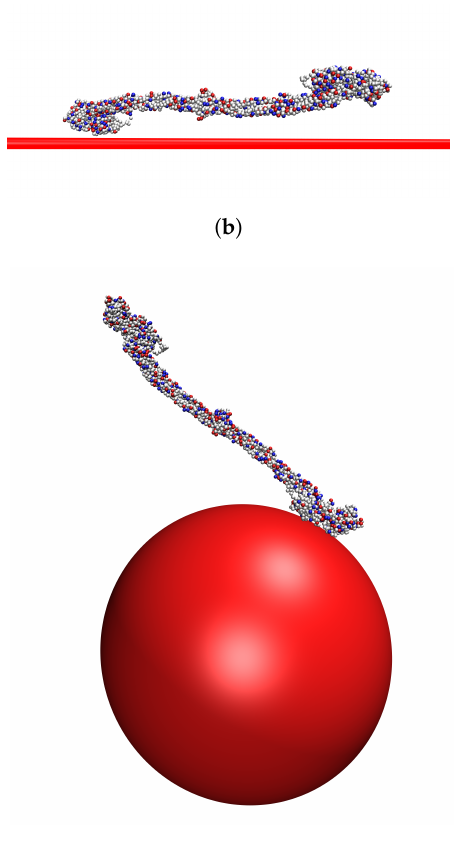
Figure 4. ( a ) The distributions of cosine of the angle between fibrinogen and the normal to the surface it is adsorbed to for two cases: when adsorbed to a nanoparticle attached to a flat surface and when adsorbed to a flat surface without nanoparticles. The surface charge density is − 0.005 e /Å 2 . ( b ) A typical orientation of fibrinogen adsorbed on the flat surface. ( c ) A typical orientation of fibrinogen adsorbed on a